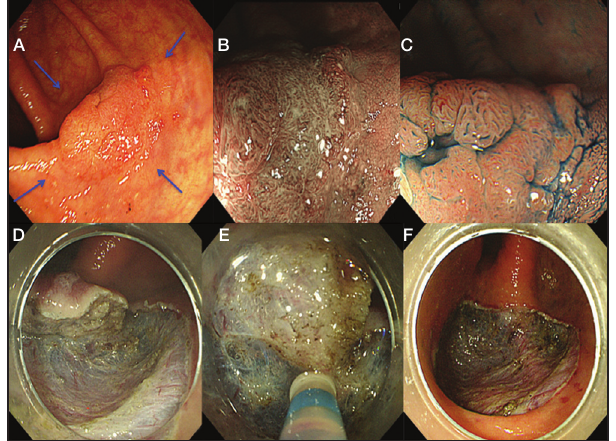
Figure 4) A A 2 cm 0-IIa lesion located in the ascending colon. B Narrow- band imaging with magnification revealed type IIIA capillary pattern. C Indigo-carmine dye with magnification demonstrated type IIIL pit pattern. D to F Endoscopic submucosal dissection performed using dual knife. F Ulcer bed after en-bloc resection. Biopsies were taken for each quadrant around the lesions because it is colitic mucosa with high risk of multifocal dysplasia (blue